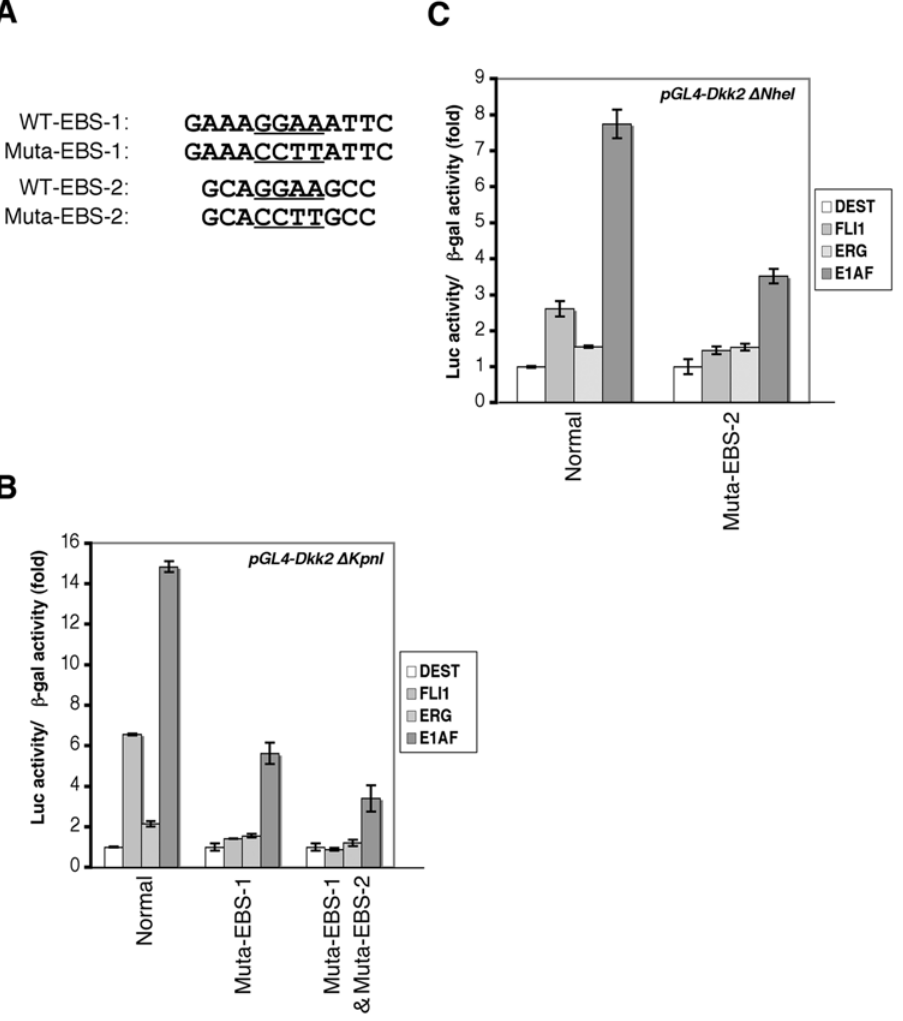
Figure 3. Mutational analysis of EBS in the DKK2 promoter. A , The substitutions in EBS-1 and EBS-2. The underlined sequences indicate the mutated sequences in EBS. B , C , The suppression of EWS/ETS-mediated activation of the DKK2 promoter by the mutations. HEK293 cells were co- transfected with mutated reporter plasmids and the expression vector. Luciferase activity was measured after 48 hours. Data are relative values with the SD for triplicate wells. Data are normalized to the value for the empty vector (pcDNA3-flagDEST) that is arbitrarily set to 1. The transfection efficiency was normalized relative to the b –galactosidase activity (See Materials and Methods).